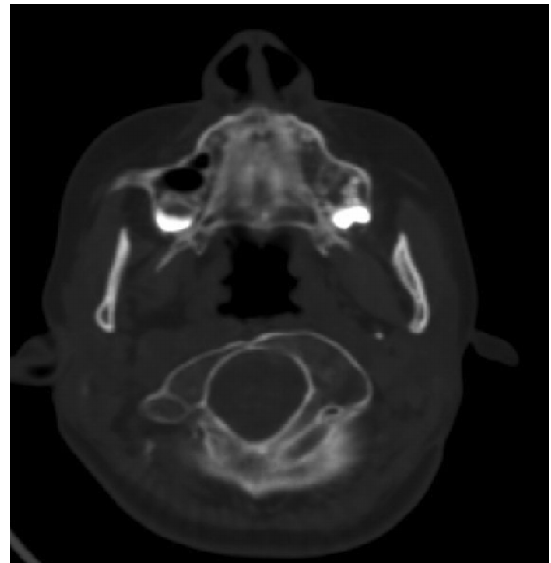
Figure 6 - An axial reformatted CT scan of a 13-year- old- boy showed assimilation of the posterior arch of the atlas, a splitting deformityoftheanteriorarchandagenesisoftheodontoidprocess.